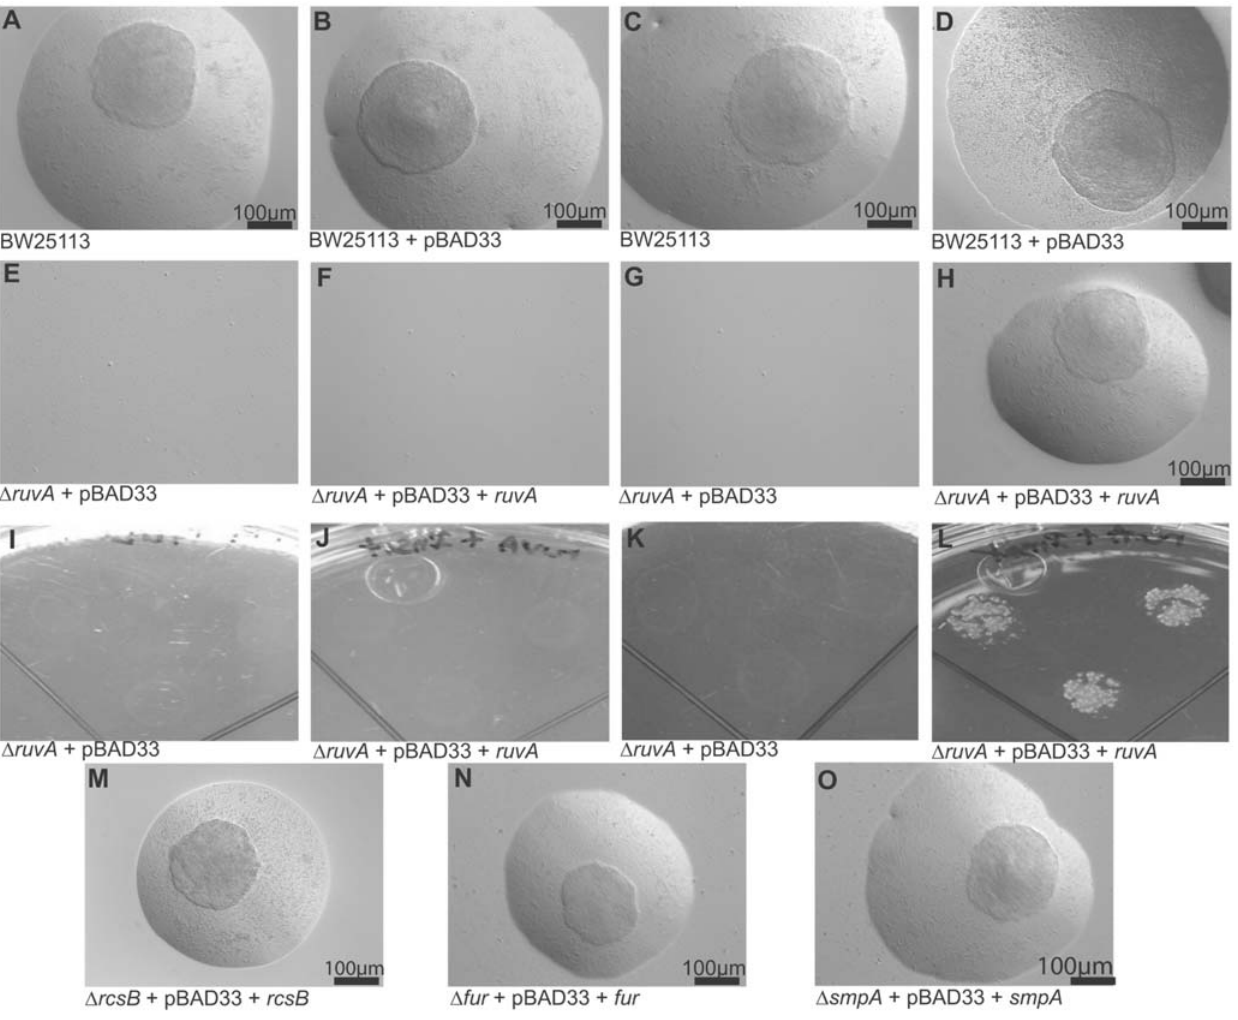
Figure 4. Complementation of deletion mutants restore L-form colony growth. A, B E. coli BW25113 alone and BW25113 transformed with empty vector pBAD33 showing ‘‘fried egg’’ morphology on LIM without 0.2% arabinose. C, D E. coli BW25113 alone and BW25113 transformed with empty vector pBAD33 showing multiple ‘‘fried egg’’ colonies on LIM with 0.2% arabinose. E, G, I, K ruvA mutant transformed with empty vector pBAD33 showing no growth on LIM with and without 0.2% arabinose. F, J ruvA mutant complemented with wild type gene showing no growth on LIM without 0.2% arabinose. H, L, M, N, O ruvA, rcsB, fur, and smpA mutants complemented with their respective wild type genes showing restoration of ‘‘fried egg’’ colony growth on LIM with 0.2% arabinose. All microscopic images are by Hoffman modulation and scale bars are 100 m m unless specified. Images I through L are gross views of LIM plates.